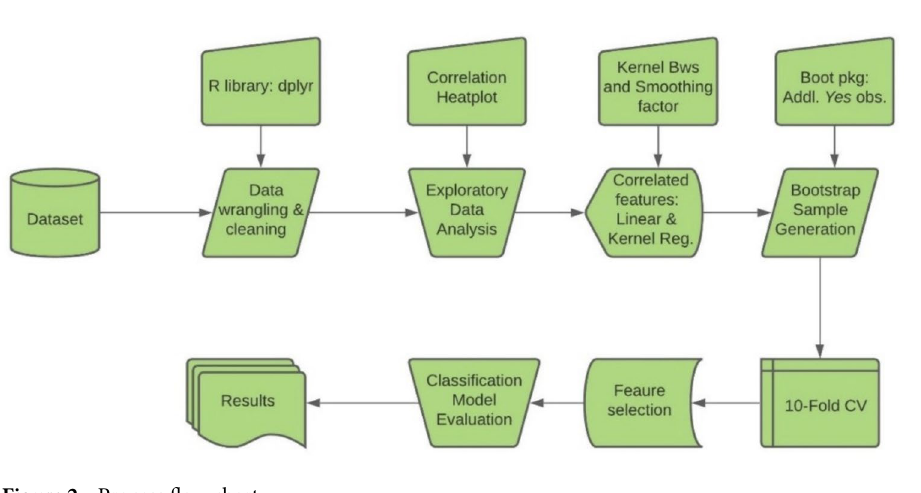
Figure 2. Process flow